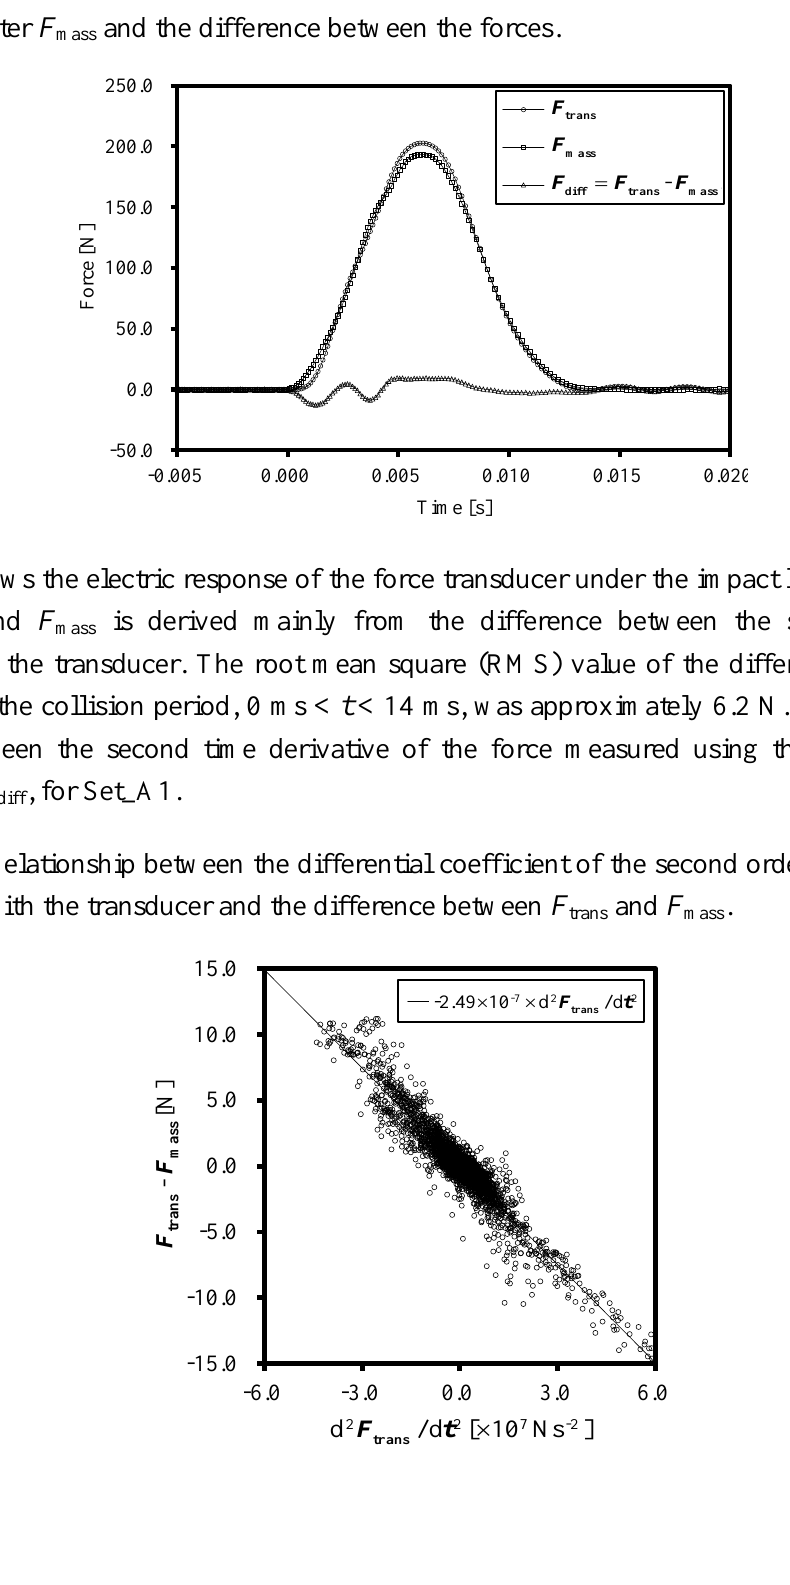
, the force measured with the trans